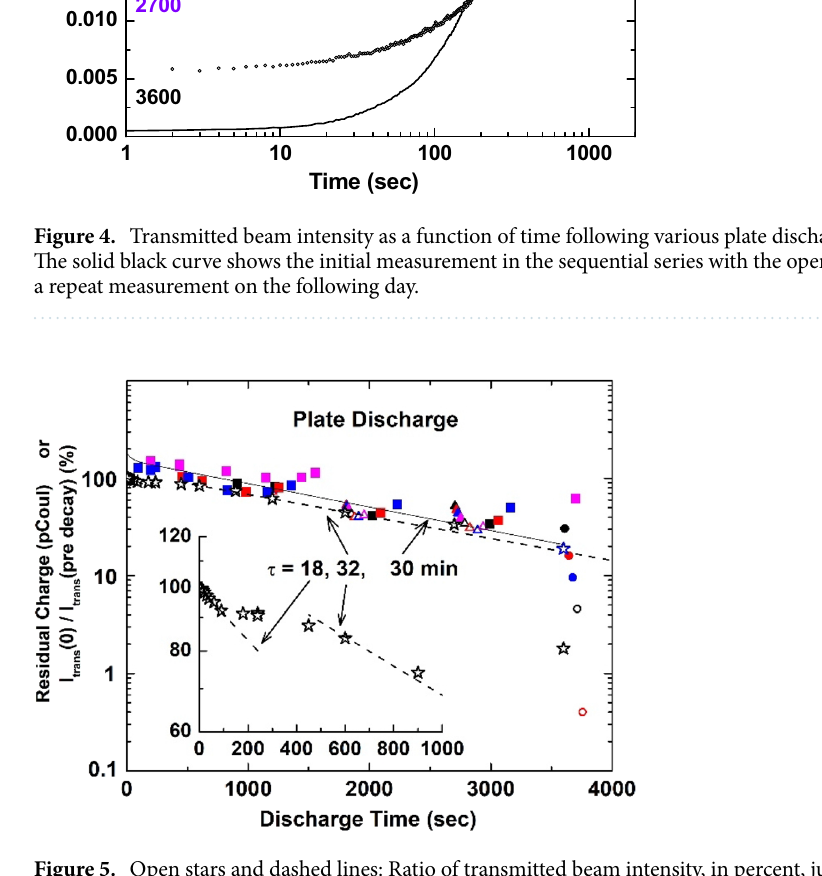
Figure 5. Open stars and dashed lines: Ratio of transmitted beam intensity, in percent, just after various blocking times with respect to the intensity just before blocking. The sequentially measured data are shown in black and the repeat measurement for a 60 min decay time is shown in blue. The inset is an expanded view of these data. Filled and open squares, triangles and circles and solid line: Residual plate charge, in pCoul, for various transmitted beam intensities obtained as described in the text. The lines are exponentials with time constants